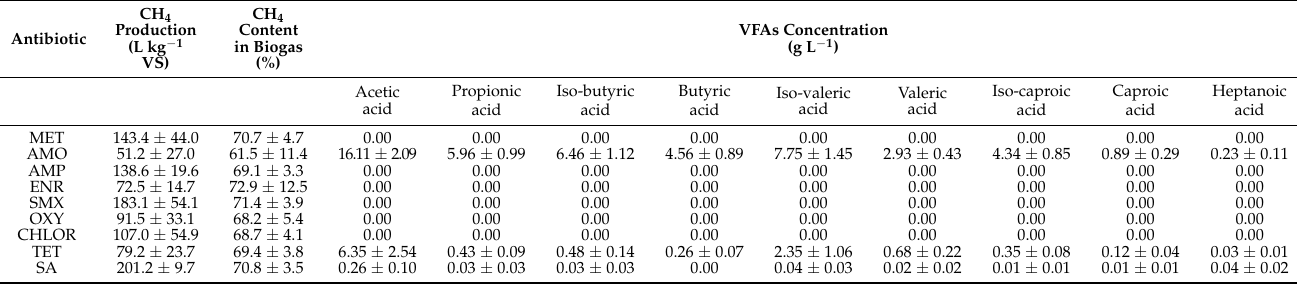
CH 4 —methane, VS—volatile solids, VFAs—volatile fatty acids, MET—metronidazole, AMO—amoxicillin, AMP—ampicillin, ENR— enrofloxacin, SMX—sulfamethoxazole, OXY—oxytetracycline, CHLOR—chlortetracycline, TET—tetracycline, SA—substrate without antibiotic (control), ± indicates standard